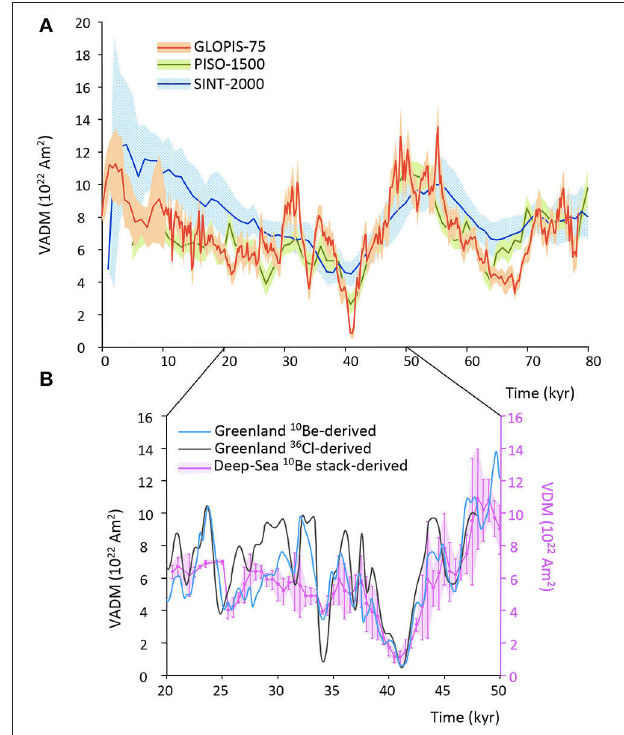
FIGURE 1 | Sedimentary (A) and cosmonuclides-derived (B) records of the earth magnetic field intensity discussed in the text, all reported in their own age models. In (A) GLOPIS-75 (in red) is from Laj et al. (2004); Sint-2000 (in blue) from Valet et al. (2005); and PISO-1500 (in green) from Channell et al. (2009). In (B) the turquoise and gray curves are for intensity curves derived from 10 Be (Muscheler et al., 2004) and 36 Cl (Wagner et al., 2000a), respectively. Both records are filtered at 1/800 years. The pink curve is derived from the deep-sea 10 Be stack from Ménabréaz et al.